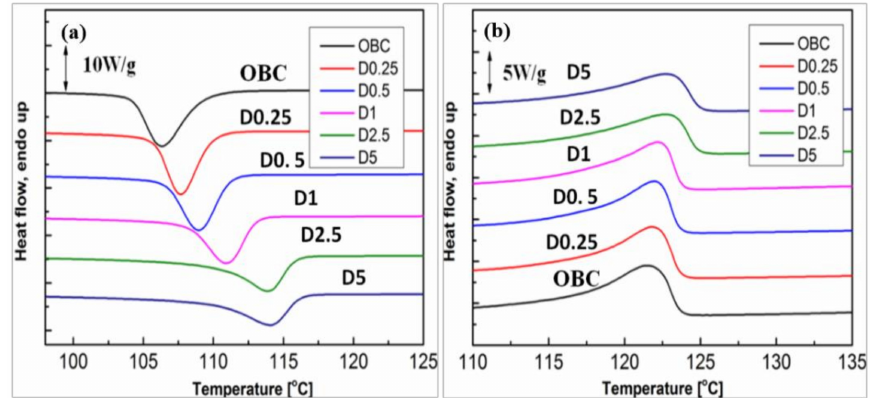
Figure 3. Differential scanning calorimetry (DSC) curves of OBC with and without different dosages of DMDBS ( a ) during the cooling process and ( b ) during the subsequent heating process. Note: Controlled heating and cooling rates of 10 ◦ C/min were applied.